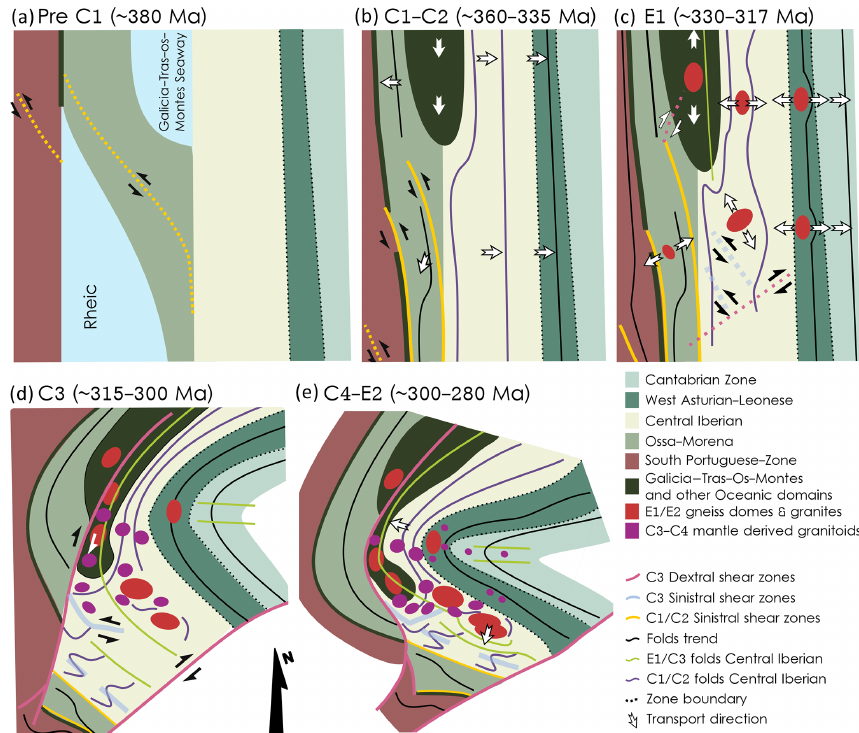
Figure 12. Preliminary kinematic proposal for the Iberian Variscides. (a) Pre-collisional stage after the opening of the Galicia–Tras-os- Montes restricted seaway (e.g., Pin et al., 2002; Gutiérrez-Alonso et al., 2008a; Arenas et al., 2016). The irregular shape of the margin and the younging westward deformation front (e.g., Dallmeyer et al., 1997) resulted in tectonic escape towards the still open Rheic Ocean (e.g., Braid et al., 2011; Murphy et al., 2016). (b) After closure of the Rheic Ocean, C1 and C2 structures formed. The Galicia–Tras-os-Montes was orogen-parallel emplaced (e.g., Martínez Catalán, 1990; Dias da Silva et al., 2020), preserving the shape of the seaway (i.e., a primary arc). (c) The gravitational collapse of the orogen produced widespread anatexis and fold interference in the hinterland and the emplacement of the foreland fold-and-thrust belt. (d) In Pennsylvanian times, a change in the far-field stress buckled the Variscan belt around a vertical axis (for details see Gutiérrez-Alonso et al., 2008a; Weil et al., 2013; Pastor-Galán et al., 2015a), creating new interference patterns and a lithospheric-scale response (see Gutiérrez-Alonso et al., 2004, 2011a; Pastor-Galán et al., 2012a). (e) When the orocline became too tight to keep rotating, new cross-cutting brittle structures (C4) formed and minor extensional collapse (E2) occurred (e.g., Fernández-Lozano et al., 2019; Dias da Silva et al.,